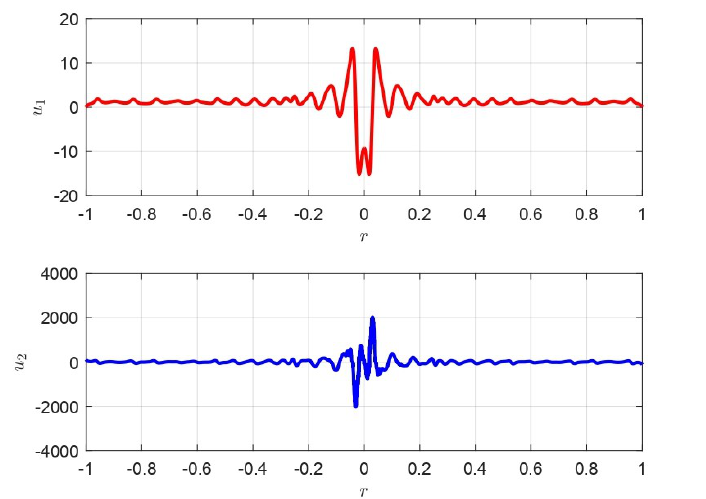
Figure 7. Recovering of the membrane achieved by u 1 = 1.2 and θλ 2 = 5 · 10 − 5 : strong instabilities take place next to the edge of the